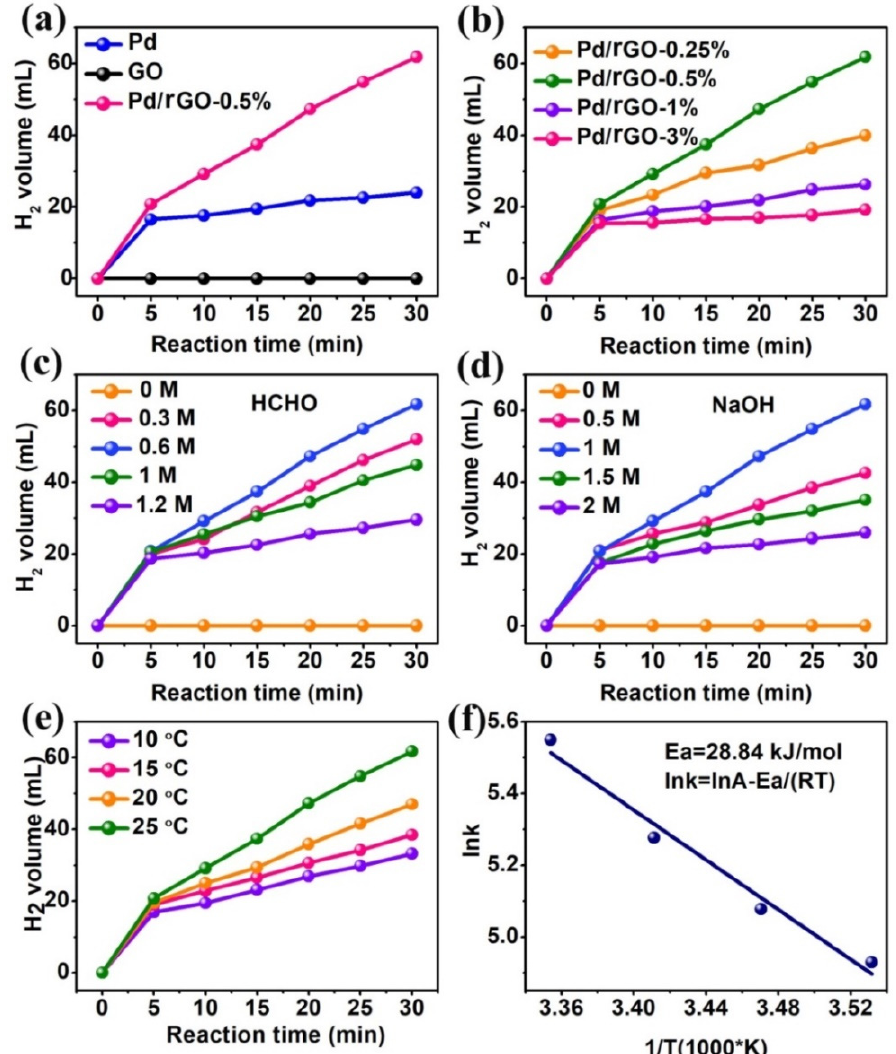
Figure 3. The effect of ( a ) catalysts and ( b ) Pd loading amount on the hydrogen generation. Reaction